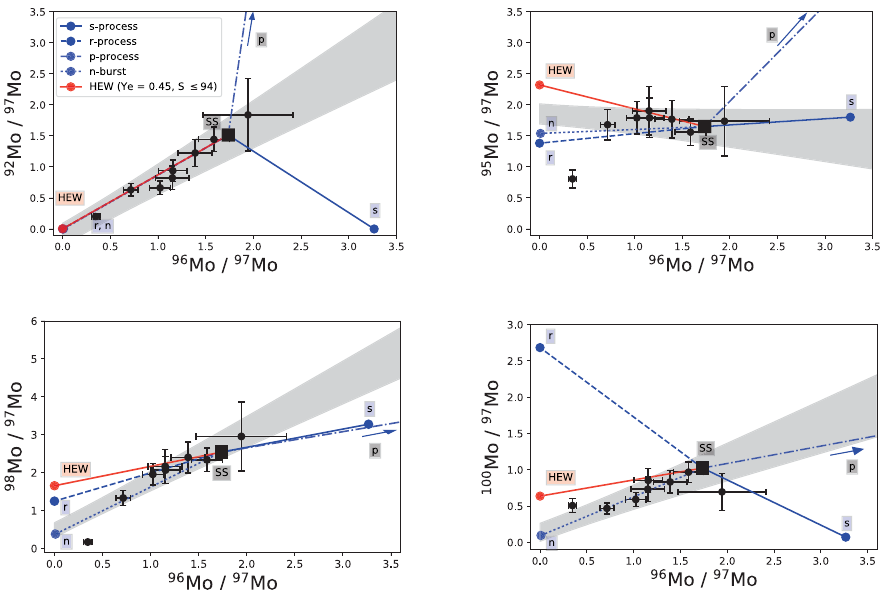
Fig. 3. Mo three-isotope plots for SiC-X grains with mixing lines for various nucleosynthetic end- members (see main text). Data uncertainties are 2σ. The error bands obtained from the 2D data fits (as in Fig. 2) are displayed as shaded areas. Filled circles indicate end-member